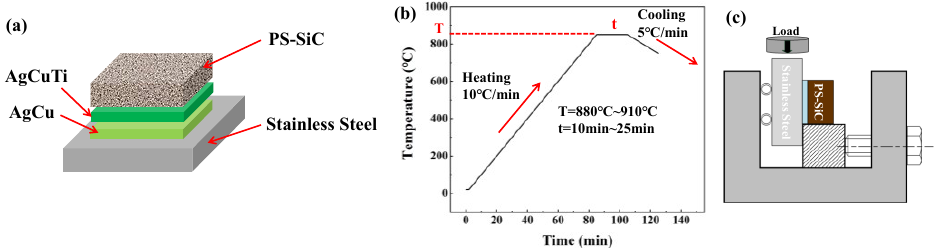
Figure 1. The course of brazing PS-SiC-stainless steel: ( a ) assembly diagram; ( b ) process parameters; and ( c ) schematic of the shear test fixture.